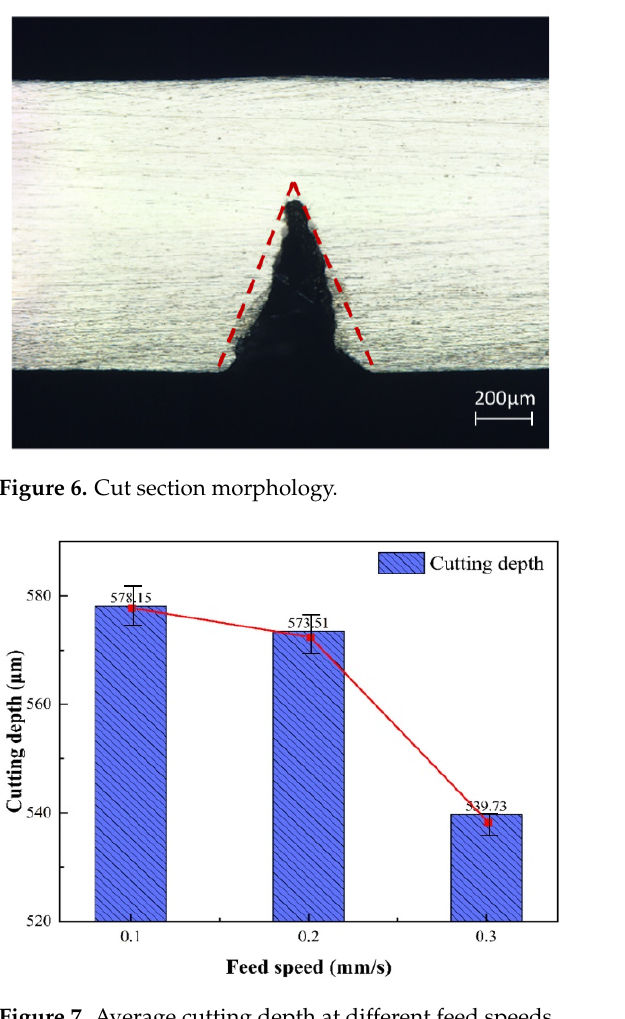
Figure 7. Average cutting depth at different feed speeds.